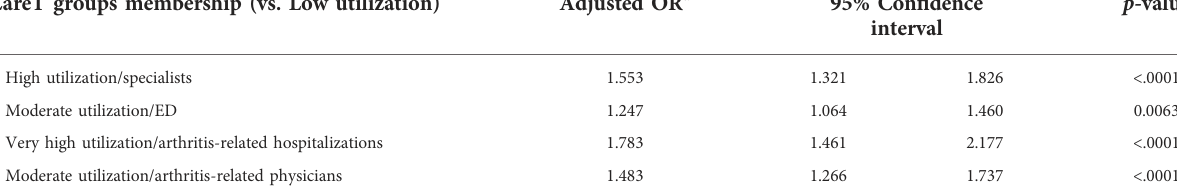
TABLE 6 Multivariable logistic regression model exploring associations between CareT groups membership and poor/fair self-perceived general health. CareT groups membership (vs. Low